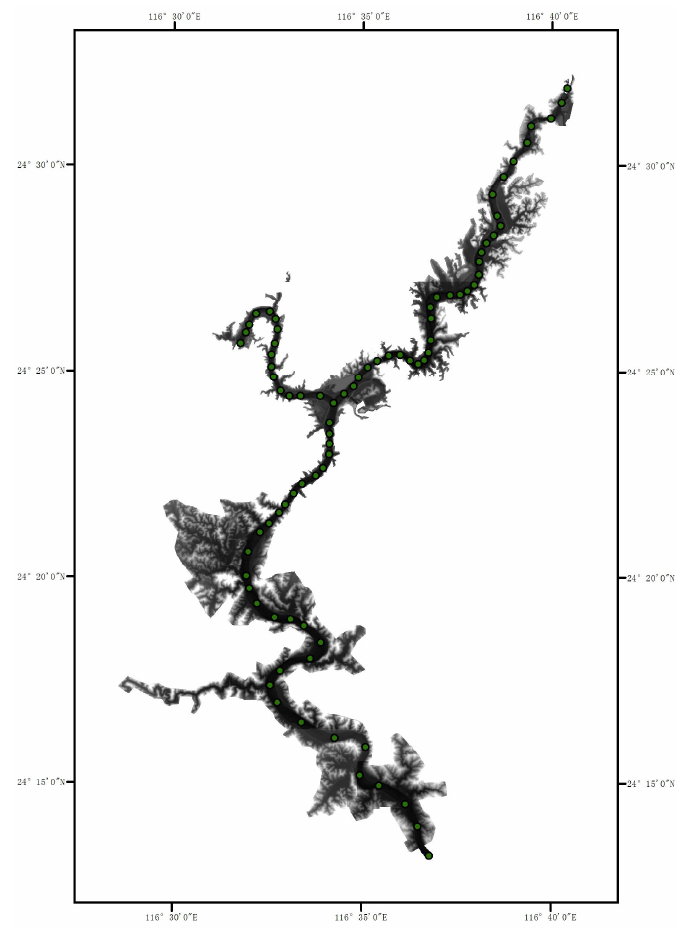
Figure 8. Different sections of backwater (marked by green points).